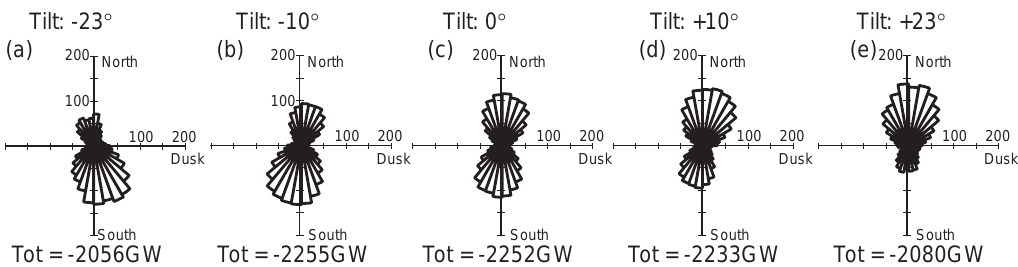
Fig. 6. Energy transfer spatial distribution at the magnetopause in the GSE coordinate system for dipole tilt angles (a) − 23 ◦ , (b) − 10 ◦ , (c) 0 ◦ , (d) + 10 ◦ , and (e) + 23 ◦ . The bar size indicates the integrated amount of energy transfer in the specific location at the magnetopause. All diagrams are taken from a run where the IMF has been southward for a long time, and the conditions before the shown time are otherwise identical. The total amount of energy transfer for each diagram (summing all bars together) is given below the